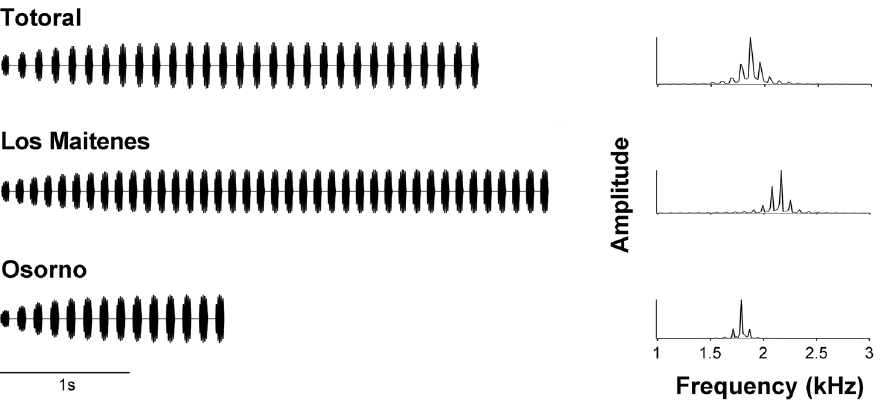
Figure 1. Synthetic stimuli of the Standard call series. Oscillograms (A) and power spectra (B) of stimuli presented to subjects of the three populations.